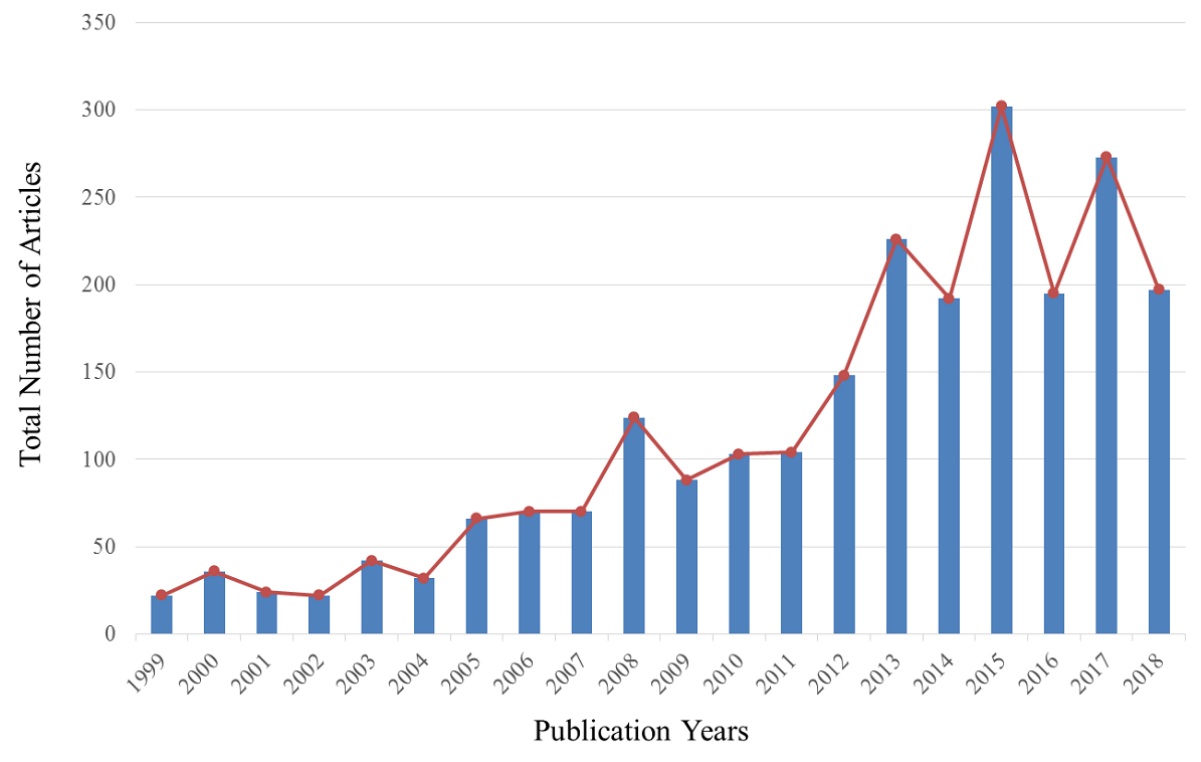
Figure 2. Graph showing the number of articles published over time.